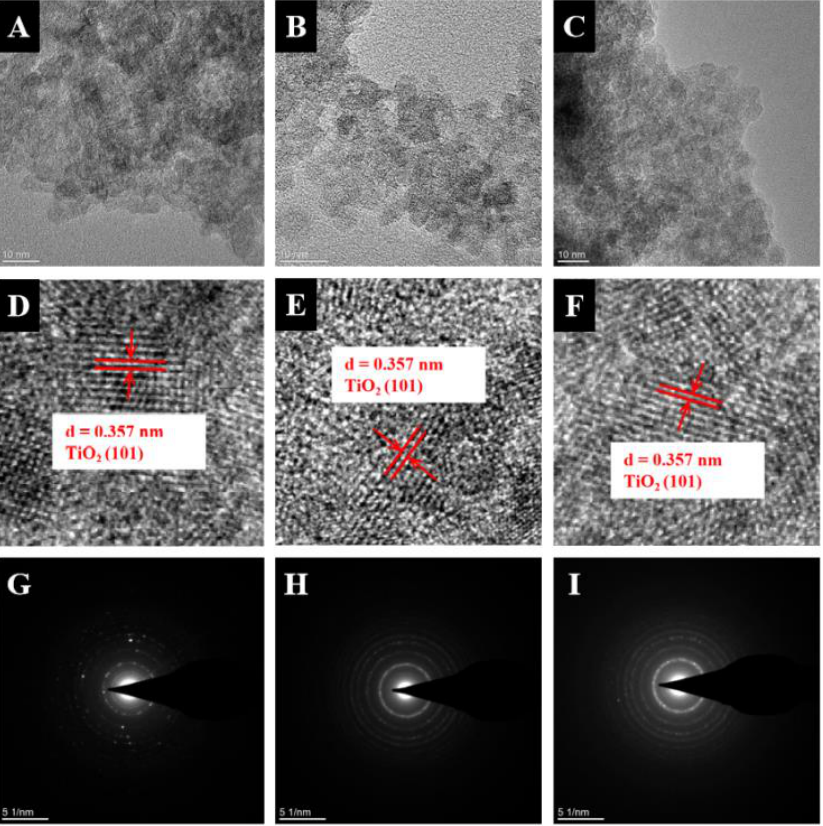
Figure 3. TEM of ( A ) THPP-TiO 2 , ( B ) THPP-Pd-TiO 2 and ( C ) THPP-Zn-TiO 2 ; HRTEM of ( D ) THPP-TiO 2 , ( E ) THPP-Pd-TiO 2 and ( F ) THPP-Zn-TiO 2 , and SAED of ( G ) THPP-TiO 2 , ( H ) THPP-Pd-TiO 2 and ( I ) THPP-Zn-TiO 2 .